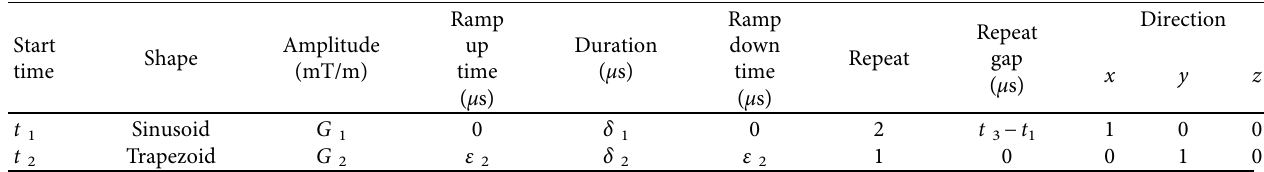
Figure 3: Te Auto- b fowchart based on the divide-and-conquer approach. Table 2: Specifcations of all gradient